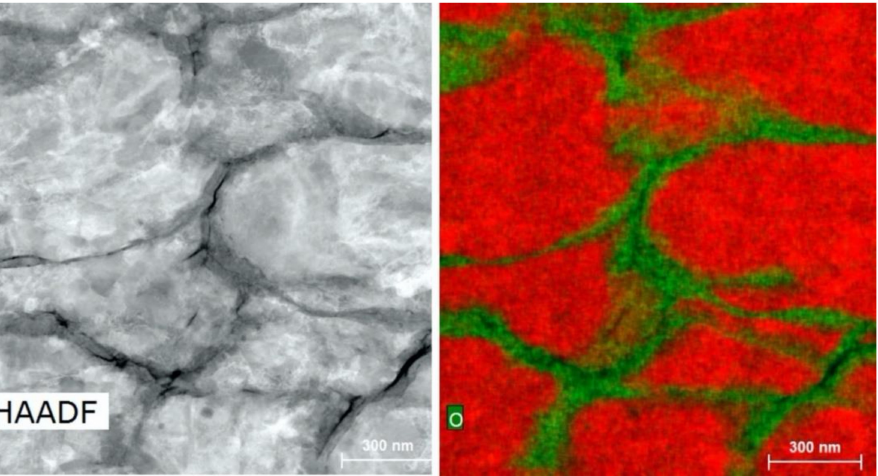
Figure 18. O segregation at the interfacial boundaries using STEM and